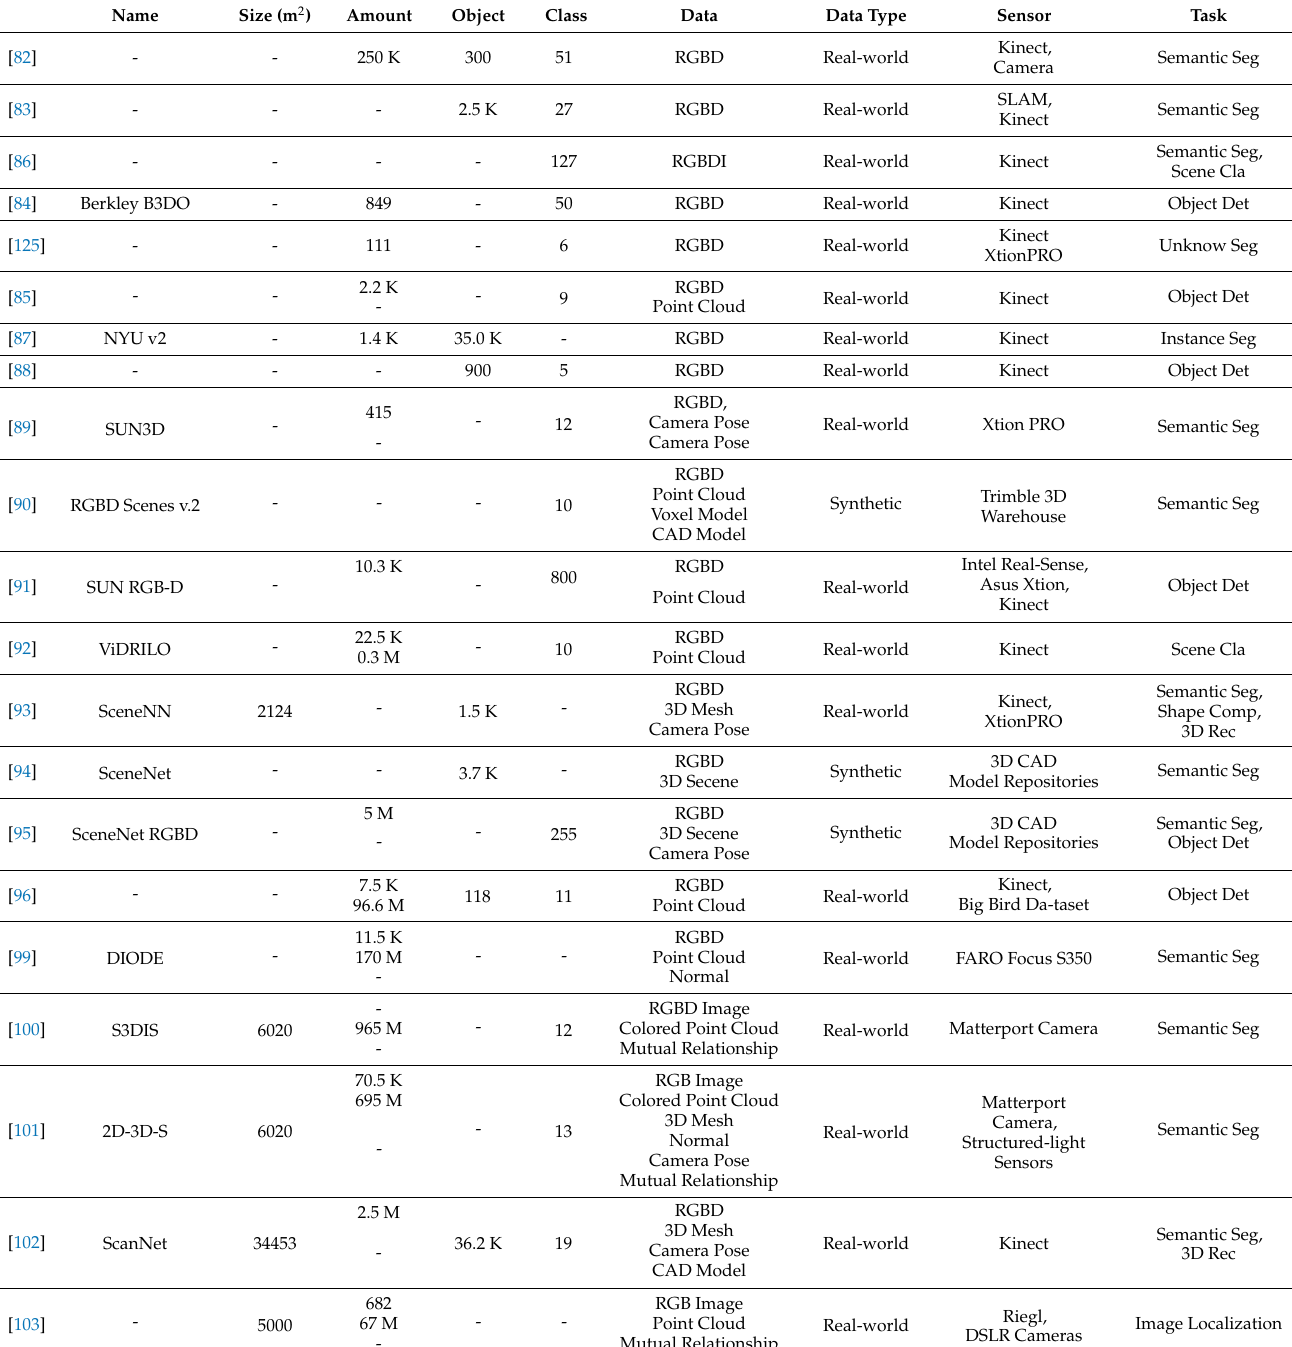
Table 2. Comparative summary of indoor scene-level datasets (Seg: segmentation; Rec: recognition; Cla: classification; Comp: